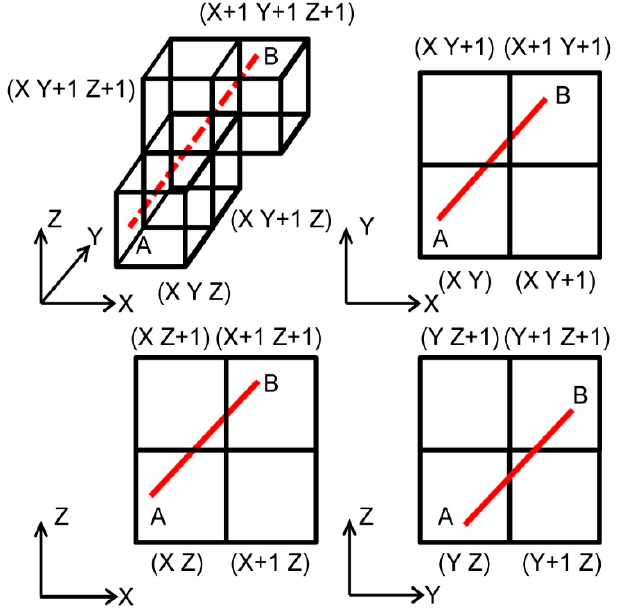
Figure 2. Determination of the voxels crossed by the GNSS signals according to the 3D traversal algorithm: red dashed line is the part of the GNSS signal inside the voxels, and all the red lines are the projection of the GNSS signal in three different planes.